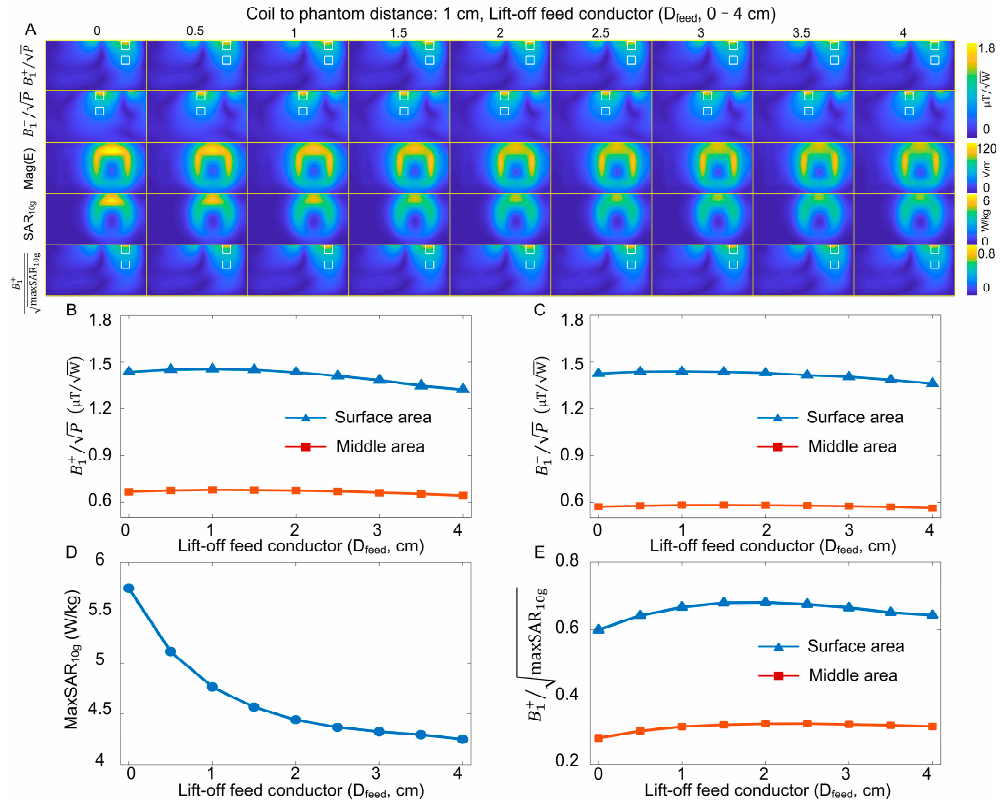
Figure 4. ( A ) Simulated B 1+ , B 1 − , E-fields, local SARs, and B 1+ SAR efficiencies of self-decoupled coils with different lift-off distances of the feed conductor (D feed ). ( B , C ) Plots of average B 1+ and B 1 − efficiencies versus D feed at the surface and middle areas, respectively. ( D ) Plots of maxSAR 10g versus D feed . ( E ) Plots of average B 1+ SAR efficiencies at the surface and middle areas. Figure 5 plots the B 1+ efficiency, SAR 10g , and B 1+ SAR efficiency maps of the original self-decoupled coil [33] and optimized self-decoupled coil with a D feed of 2 cm. B 1+ maps and B 1 + SAR efficiency are shown in the central axial slice, while SAR 10g is shown in the axial slice that is close to the feed port. We chose this slice to show SAR 10g , as the maximum SAR 10g is located near the feed conductor. Compared with the original self-decoupled coil, the B 1+ SAR efficiency of the optimized self-decoupled coil has 11.5% and 18.8% improvements at the surface and in the middle areas of the human body,